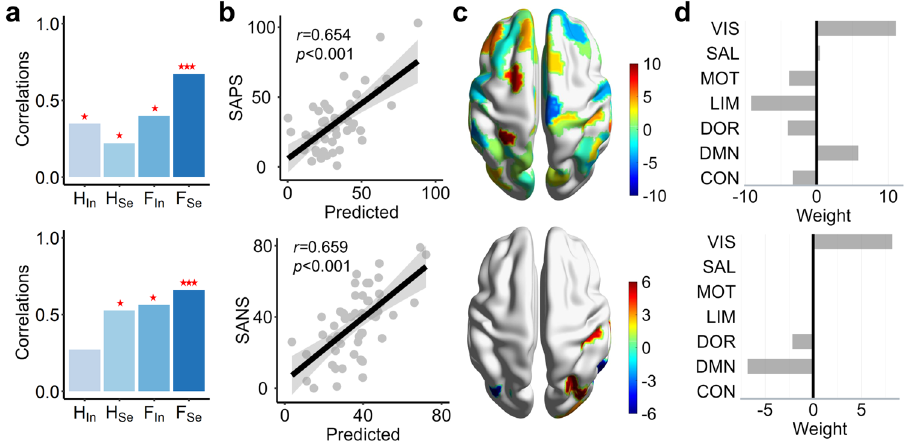
Fig. 3 Prediction of SANS and SAPS scores. a Four brain network measures, integration strength H In , segregation strength H Se , integration variability F In , and segregation variability F Se , were used to predict the SAPS (upper panel) and SANS (lower panel) scores. The bar charts are correlations between real SAPS/SANS scores and predicted scores using different brain measures. *** p < 0.001, ** p < 0.01, * p < 0.05. b The correlation between SAPS (upper panel)/SANS (lower panel) scores and predicted scores for segregation variability F Se . c The weights of regions in the best predictions of SAPS (upper panel)/SANS (lower panel) scores were mapped to the brain surface. d The summed weight of the regions in seven functional systems in the best predictions of SAPS (upper panel)/SANS (lower panel) scores (see similar results for the brain parcellation of 500 regions in Supplementary Fig.